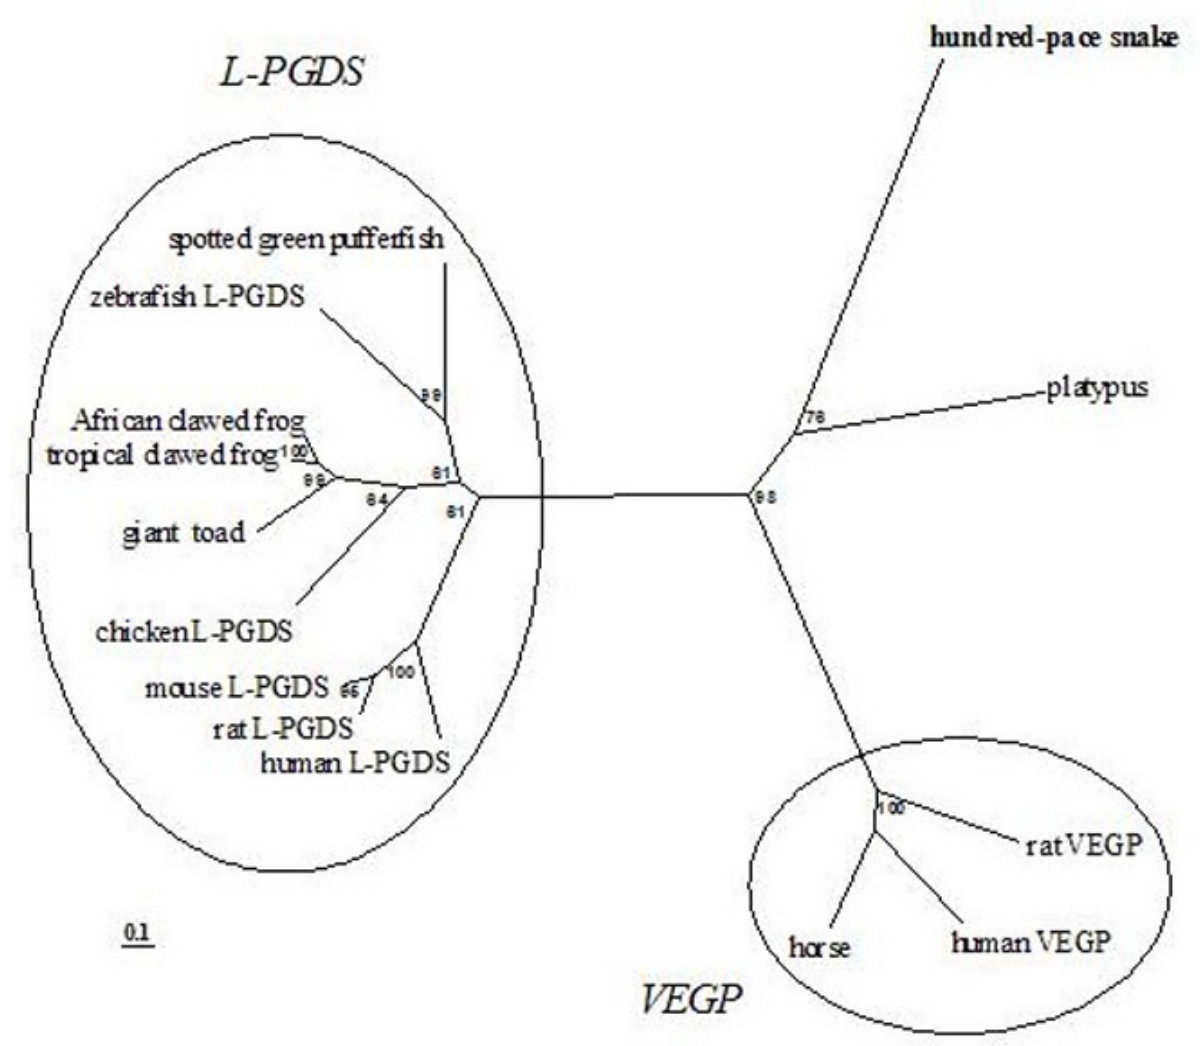
Figure 2. Phylogenetic tree analysis on amino acid sequences of some homologues related to d-lipo using ClustalW program. The values at the forks indicate the percentage of trees in which this grouping occurred after bootstrapping the data with 1000 replicates (shown only when > 60%). The scale bar shows the number of substitutions per